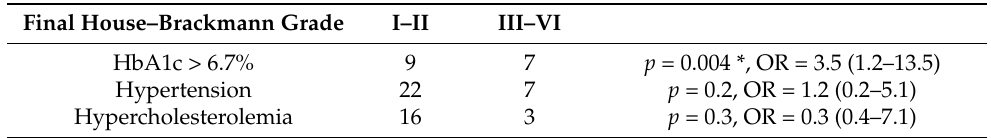
Table 6. Correlation of final House–Brackmann (HB) grades and glycosylated hemoglobin HbA1c, hypertension, and hypercholesterolemia with multiple logistic regression analysis—odds ratio (95% confidence interval). * Statistical significance ( p <